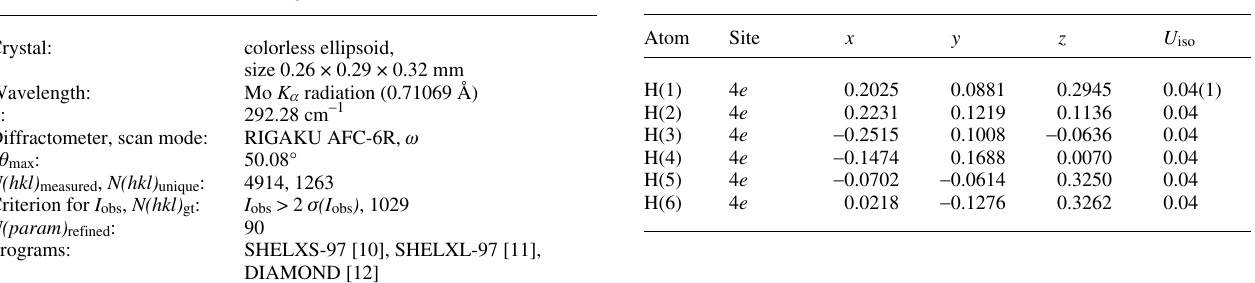
Table 17. Atomic coordinates and displacement parameters (in Å 2 ) . Table 16. Data collection and